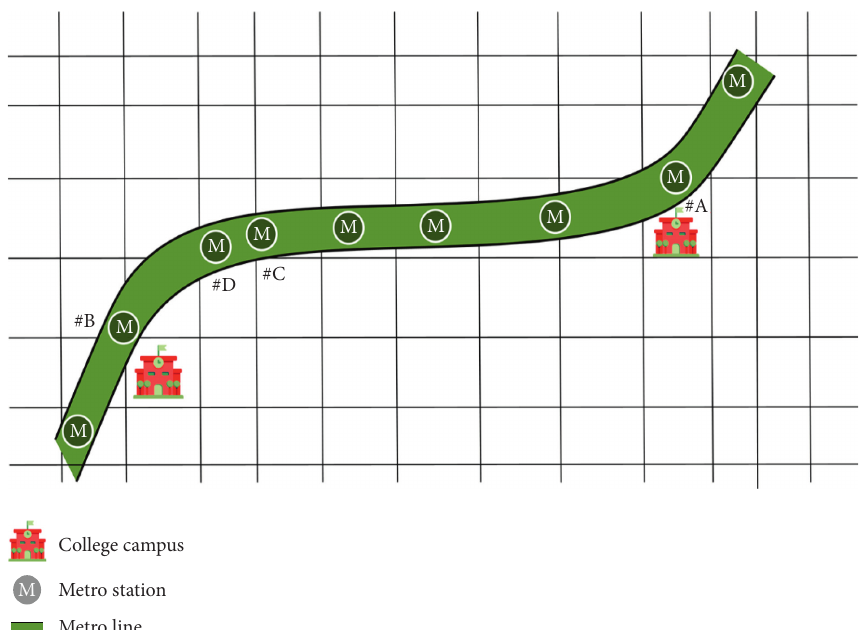
Figure 1: Illustrations of hidden spatial correlations between metro